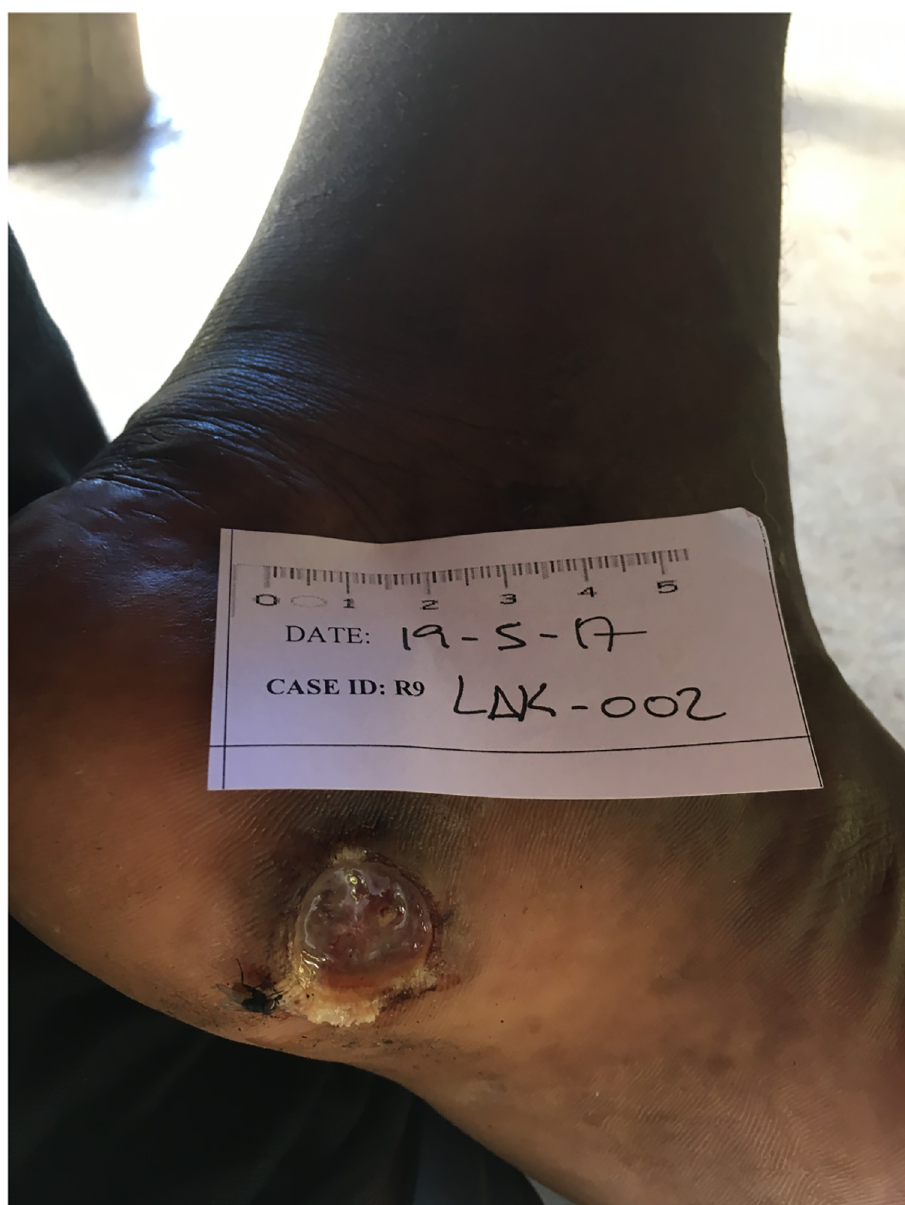
shotgun sequencing. DNAs for both F . necrophorum and Peptostreptococcaceae were detected by shotgun